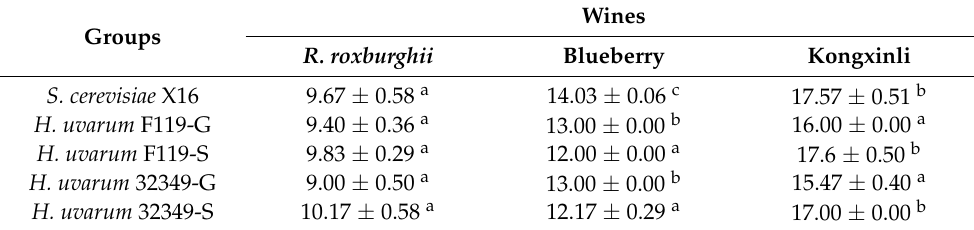
Table 1. Fruit wines alcohol content using different fermentation